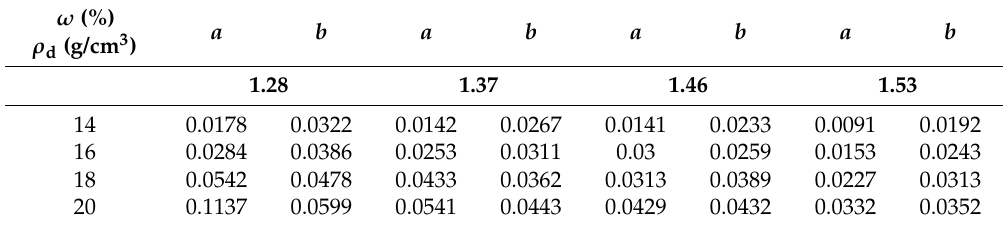
Figure 18. Transformed hyperbolic stress-strain curve: ( a ) ρ d = 1.28 g/cm 3 ; ( b ) ρ d = 1.37 g/cm 3 ; ( c ) ρ d = Table 3. Parameters a and b . Table 3. Parameters a and b .